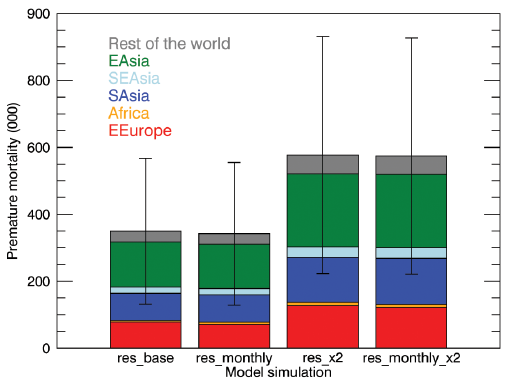
Figure 10. Simulated global annual premature mortality (cardiopul- monary diseases and lung cancer for persons over the age of 30 years) due to exposure to ambient PM 2 . 5 from residential emis- sions. Results are shown for standard emissions (res_base and res_monthly) and where residential emissions have been doubled (res_ × 2 and res_monthly_ × 2). Mortality is shown for Eastern Eu- rope and the Russian Federation (EEurope), Africa (Africa), South Asia (SAsia), Southeast Asia (SEAsia), East Asia (EAsia), and the rest of the world (as defined by the coloured regions in Fig.